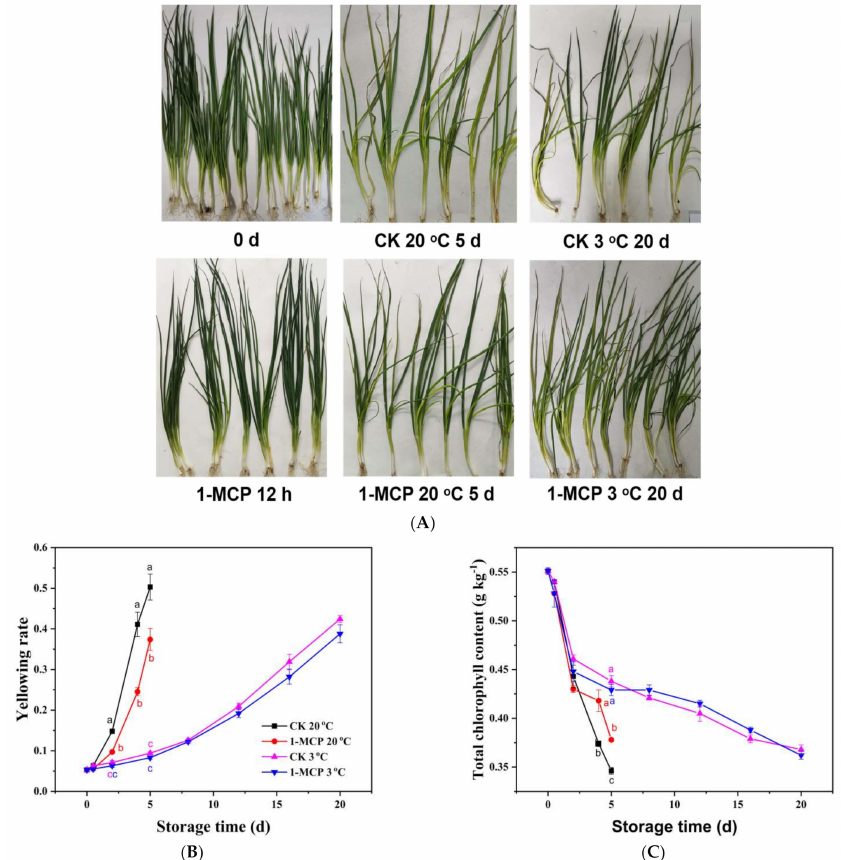
Figure 1. Appearance ( A ), yellowing rate ( B ) and total chlorophyll content ( C ) of 1-MCP treated and untreated chives during storage at 20 ◦ C and 3 ◦ C. Data are expressed as the mean of triplicate samples. Vertical bars represent the standard errors of the means. The different letters at each time point indicate a difference among the chives